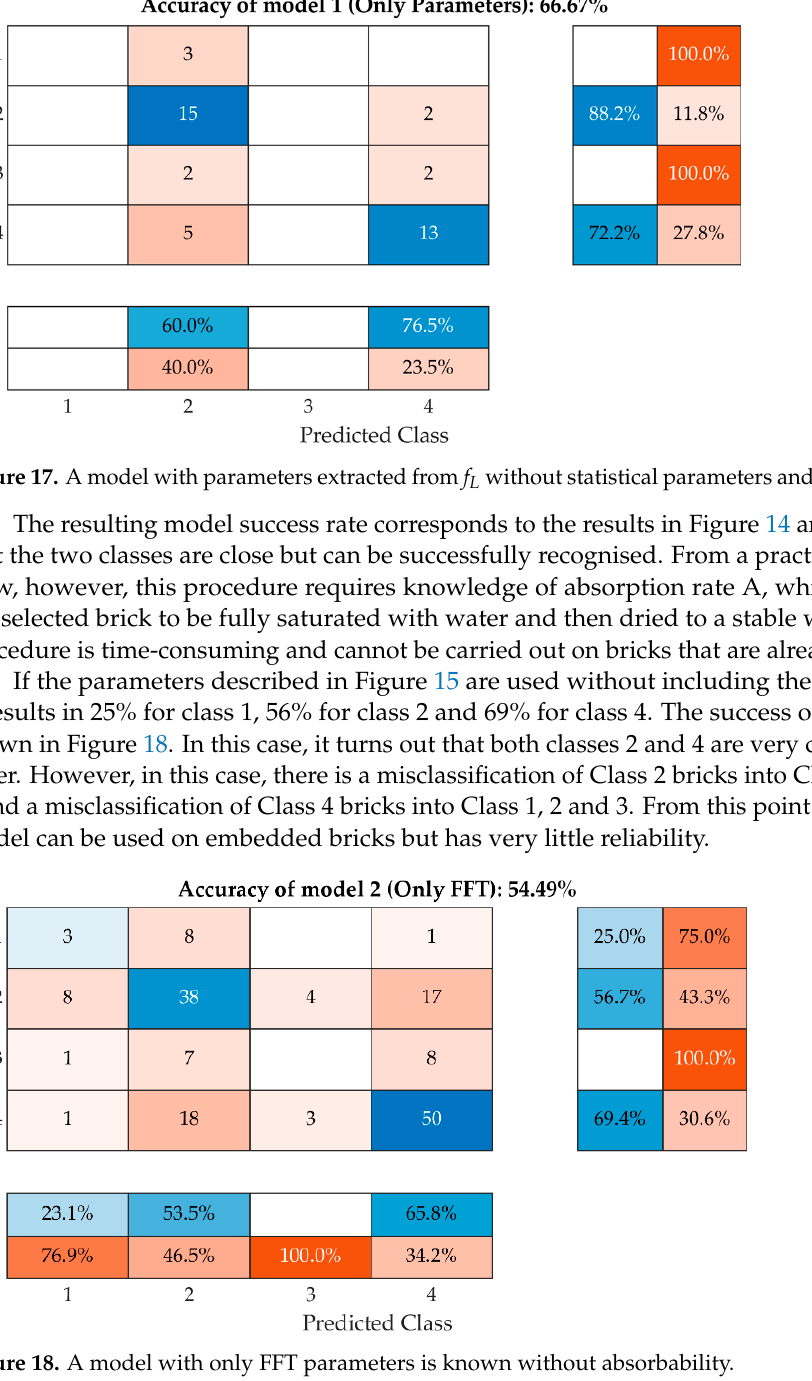
Figure 18. A model with only FFT parameters is known without absorbability.